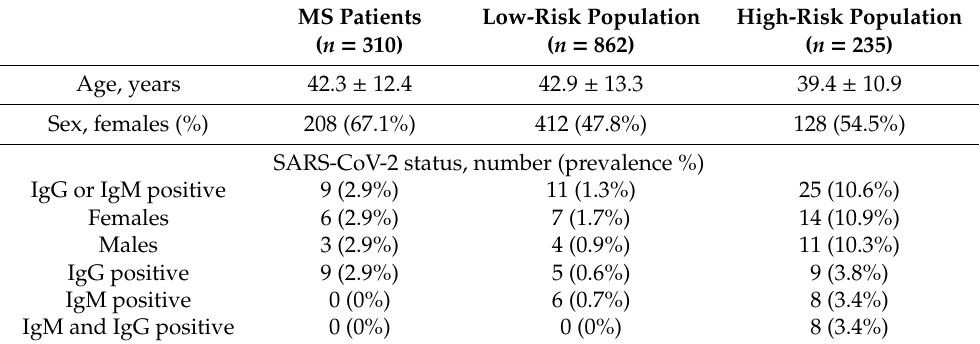
Table 1. Demographics and SARS-CoV-2 IgG / IgM status in multiple sclerosis (MS) patients, low-risk population, and high-risk